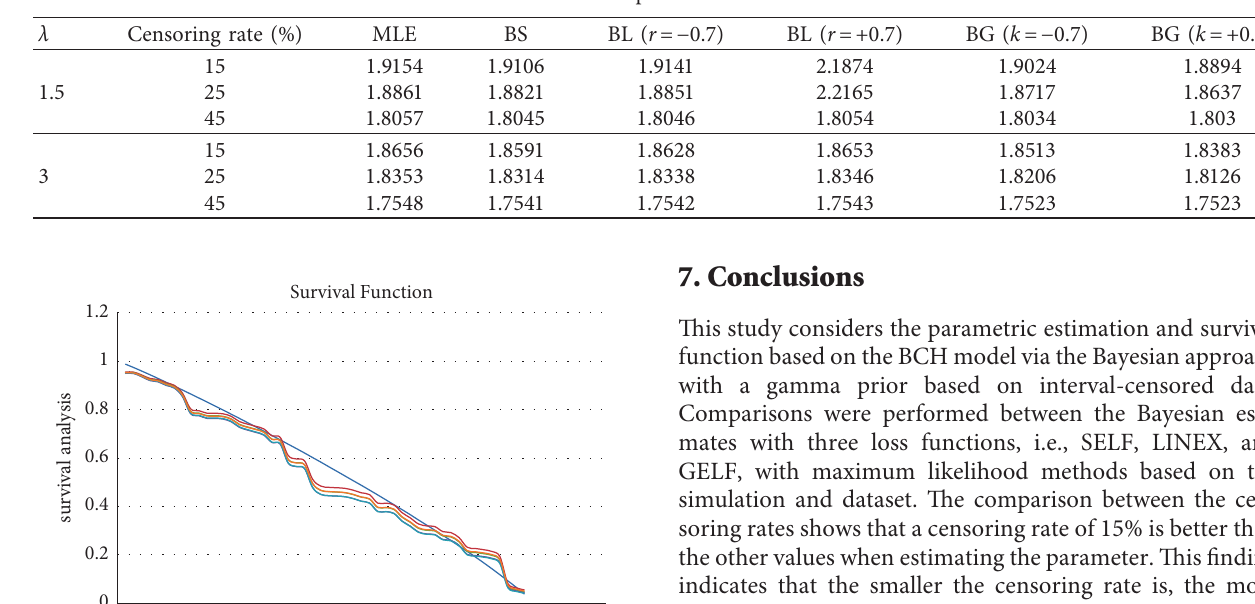
Table 9: Estimations of θ with the cure fraction dependent on the interval-censored data from the dataset.